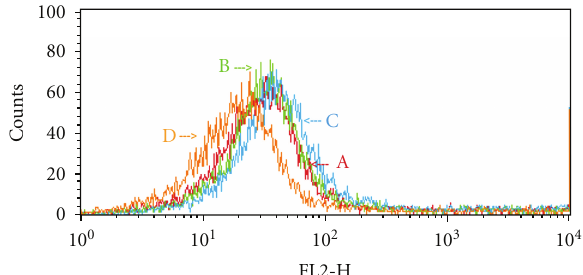
Figure 3: Mitochondrial membrane potential of HO-8910 cells was measured using flow cytometry with JC-1 staining 6h after photodynamic action of hypocrellin B. The spectral shift of the fluorescence curve to the left indicates mitochondrial membrane depolarization. A: sham irradiation; B: hypocrellin B treatment alone; C: light irradiation alone; D: photodynamic action of hypocrellin